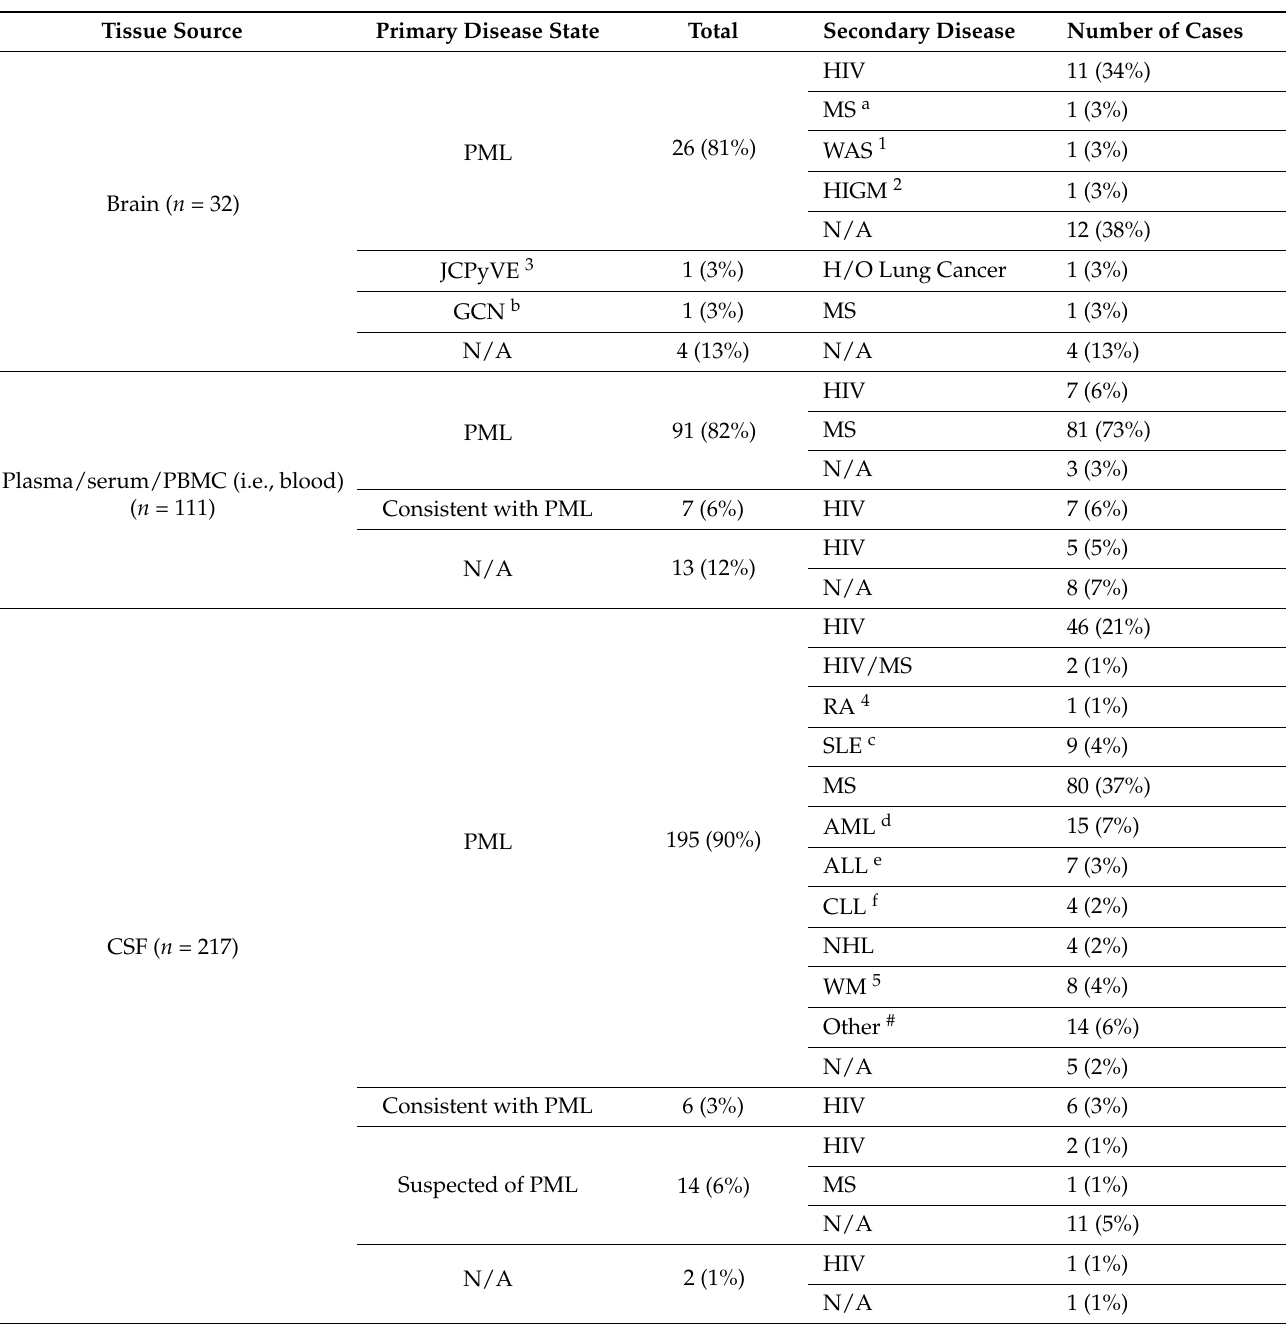
Table 1. Summary of the 989 NCCR